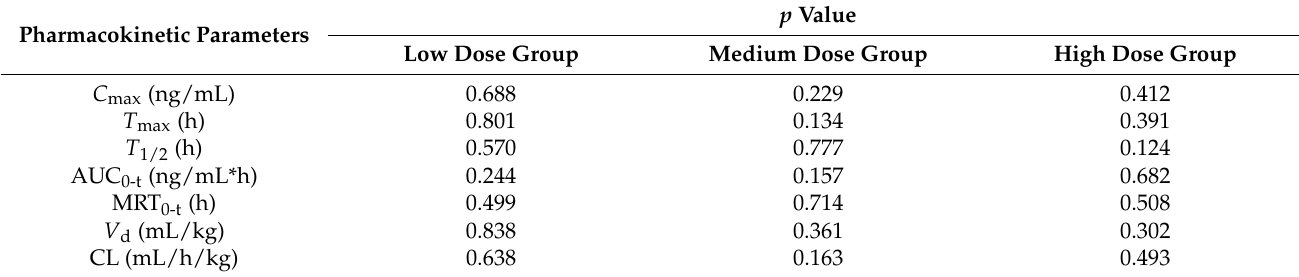
Table 7. The statistical difference of the main PK parameters of GA in different dose groups.